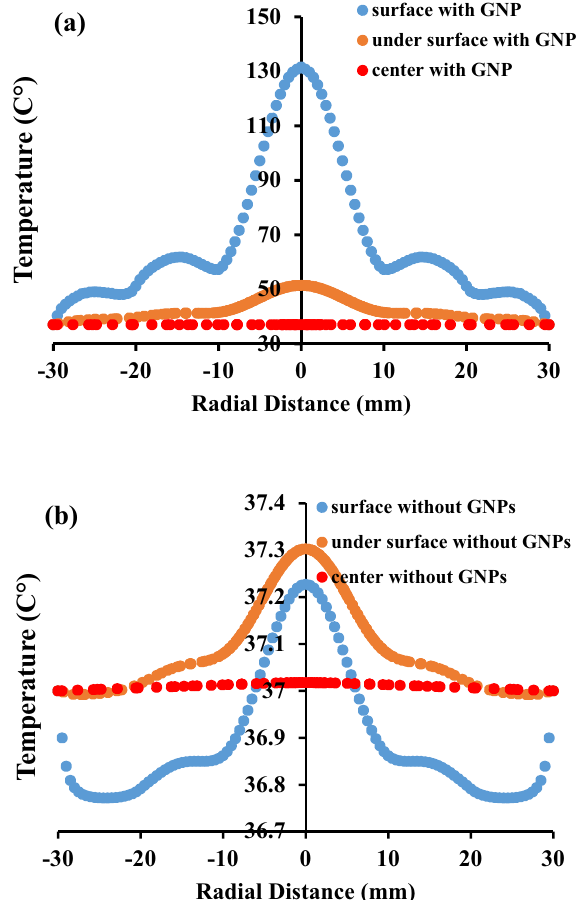
Figure 7. Temperature of the tumor along three lines in different depths of the tumor and a comparison of the temperature ( a ) with and ( b ) without any GNPs.